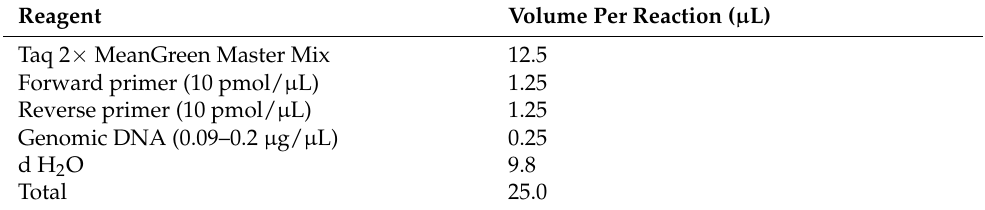
Table 1. MeanGreen PCR reaction mix.